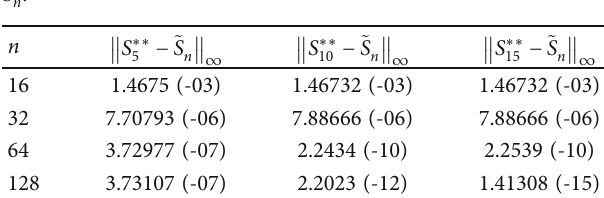
Table 6: Error norms between S ∗∗ ~ . S n